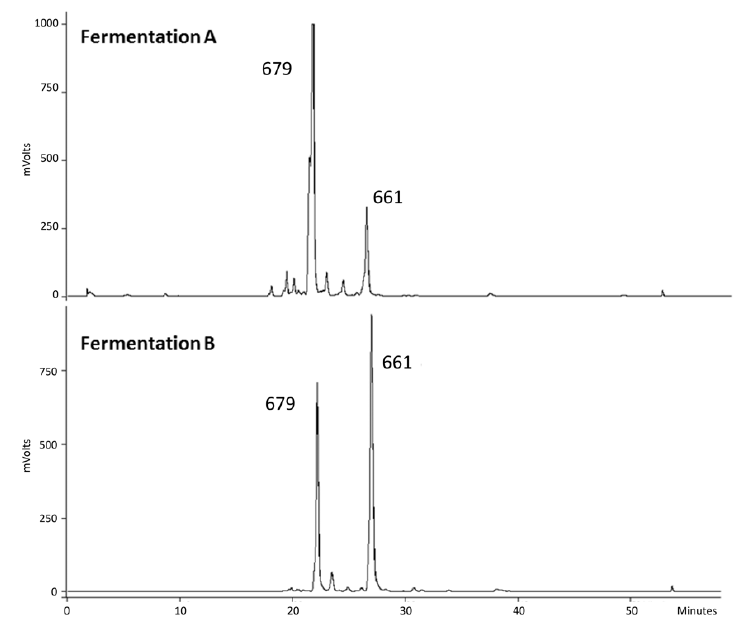
Figure 7. Difference in the ratio of the sophorolipid products in the two 30-L fermentations: acidic (22.4 min, 679 m / z ) and lactonic (26.6 min, 661 m / z ) di-acetylated C16:0 sophorolipids.